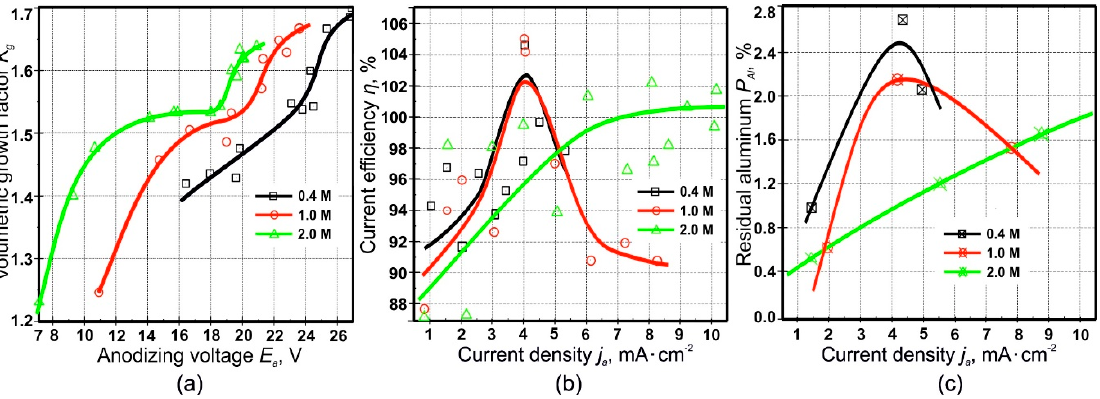
Figure 4. ( a ) Dependence of volumetric growth factor K g on anodic voltage E a in stationary growth region II of porous alumina films samples fabricated at current densities j a of 0.5–10 mA ∙ cm − 2 and sulfuric acid concentrations of 0.4–2.0 M. Dependence of current efficiency η ( b ) and fraction of un ‐ oxidized aluminum P Al ( c ) on the anodic current density for sulfuric acid concentrations of 0.4, 1.0, and 2.0 M. The lines are just guides to the eye.